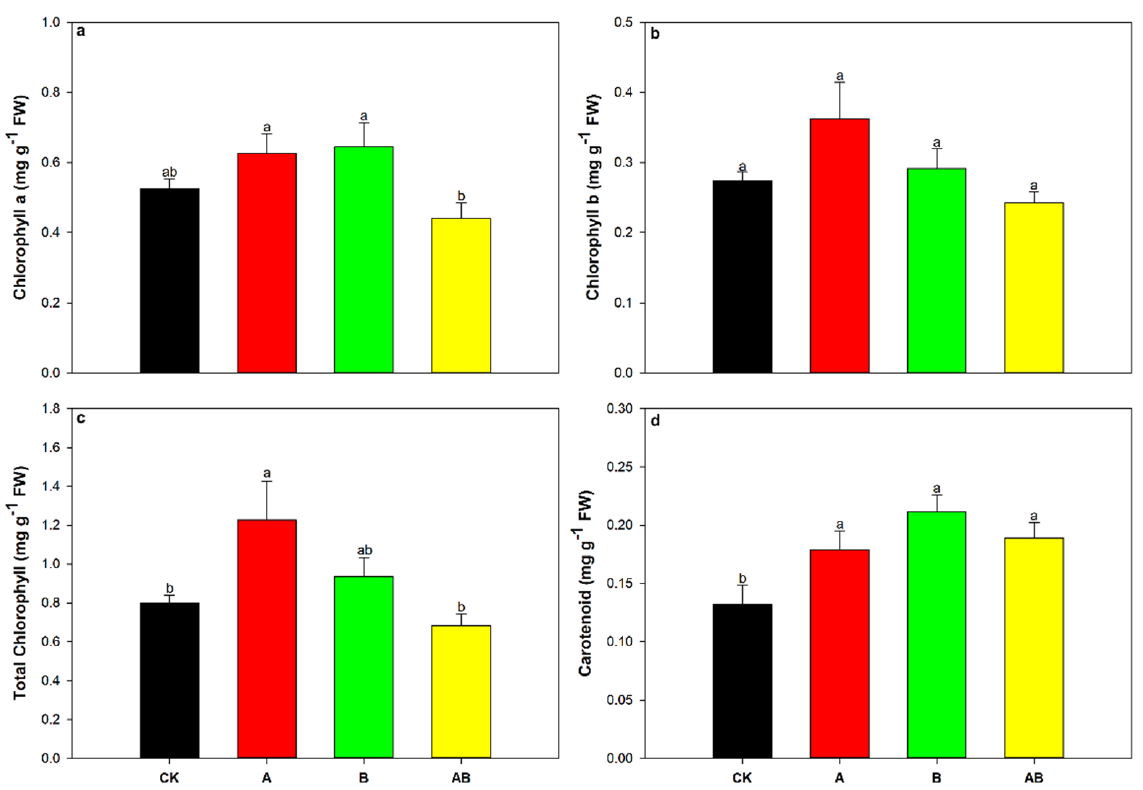
Figure 3. Effects of AMFs and biochar on ( a ) chlorophyll a, ( b ) chlorophyll b, ( c ) total chlorophyll, and ( d ) carotenoid contents. Data are means of five replicates ± SEs. Different letters above the columns indicate significant differences according to Duncan’s test at p < 0.05. FW, fresh weight; CK, control; A, arbuscular mycorrhizal fungi; B, biochar; AB, arbuscular mycorrhizal fungi and biochar.